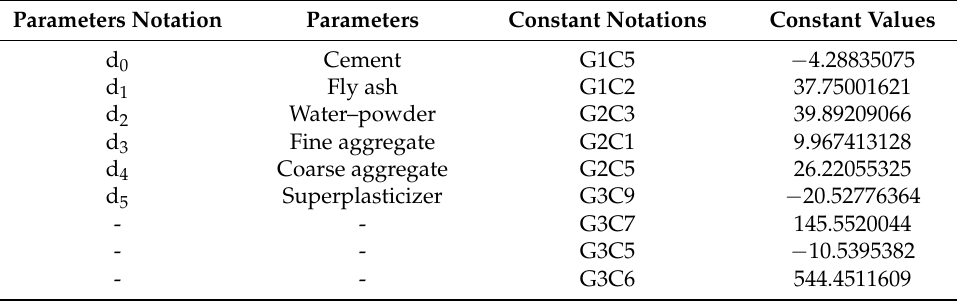
Figure 9. GEP model expression trees of SCC. Table 6. Constant and notation used to prepare empirical equation.